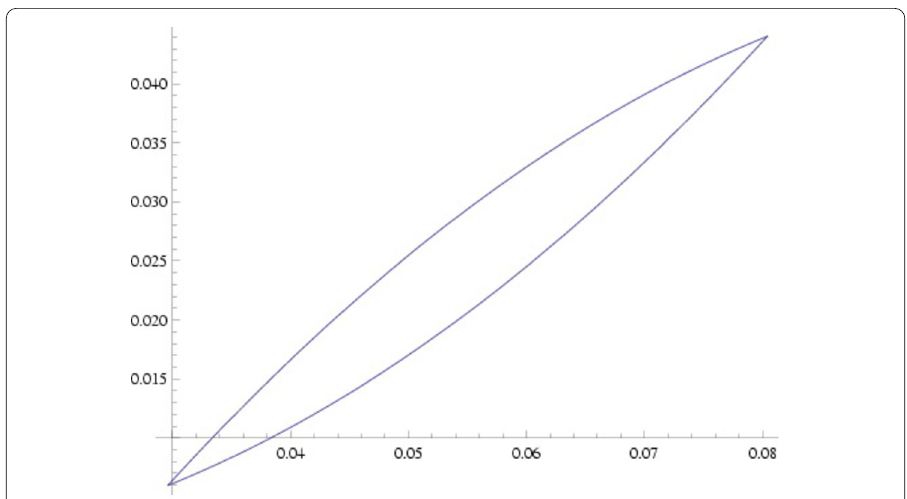
Figure 1 Phase portrait of an approximate solution of (17) in the xy